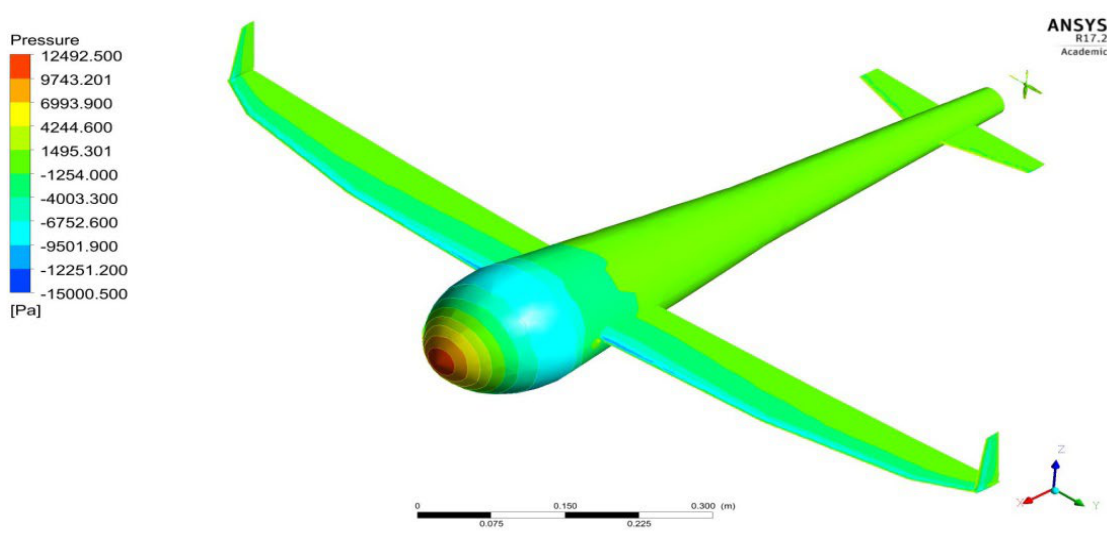
Figure 22. Hydrodynamic pressure distributions on UAV. The velocity flow over a UAV is apparently the same at different locations. The different view of velocity over the UAV is shown in Figure 23. The input velocity on